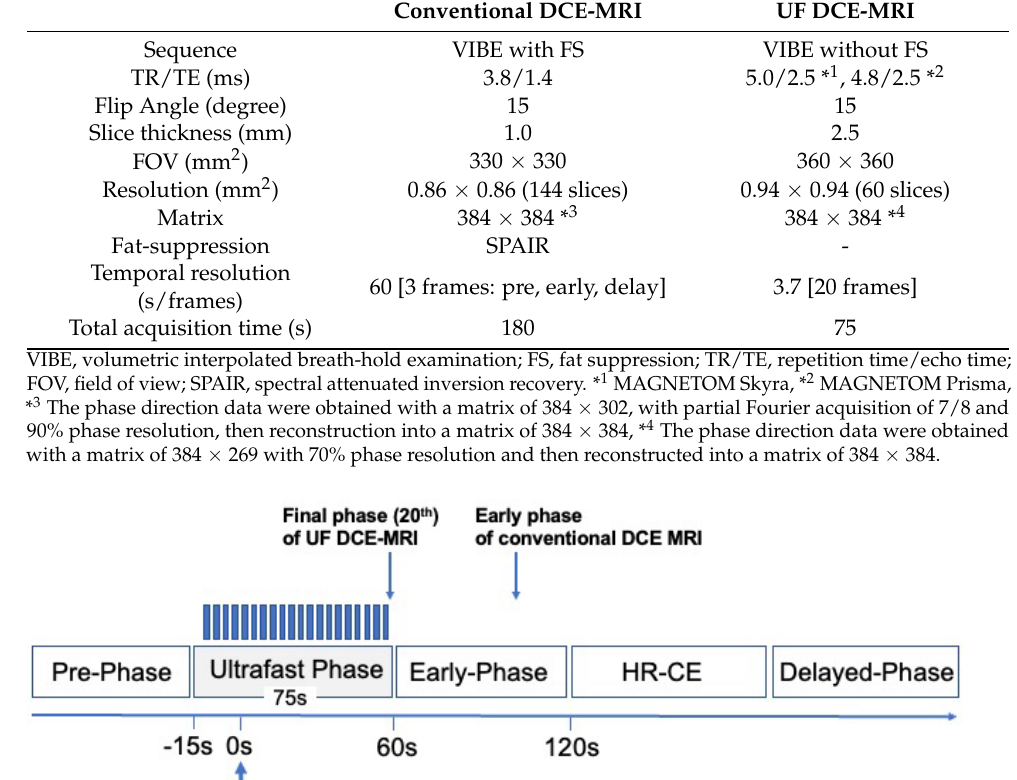
Figure 2. Schematic explanation of our dynamic protocols, including the UF DCE − MRI. UF DCE − MRI using CS − VIBE: 20 frames (pre+19 frames), 3.7 s/frame. UF, ultrafast; VIBE, volumetric interpolated breath − hold examination; HR, high − resolution.